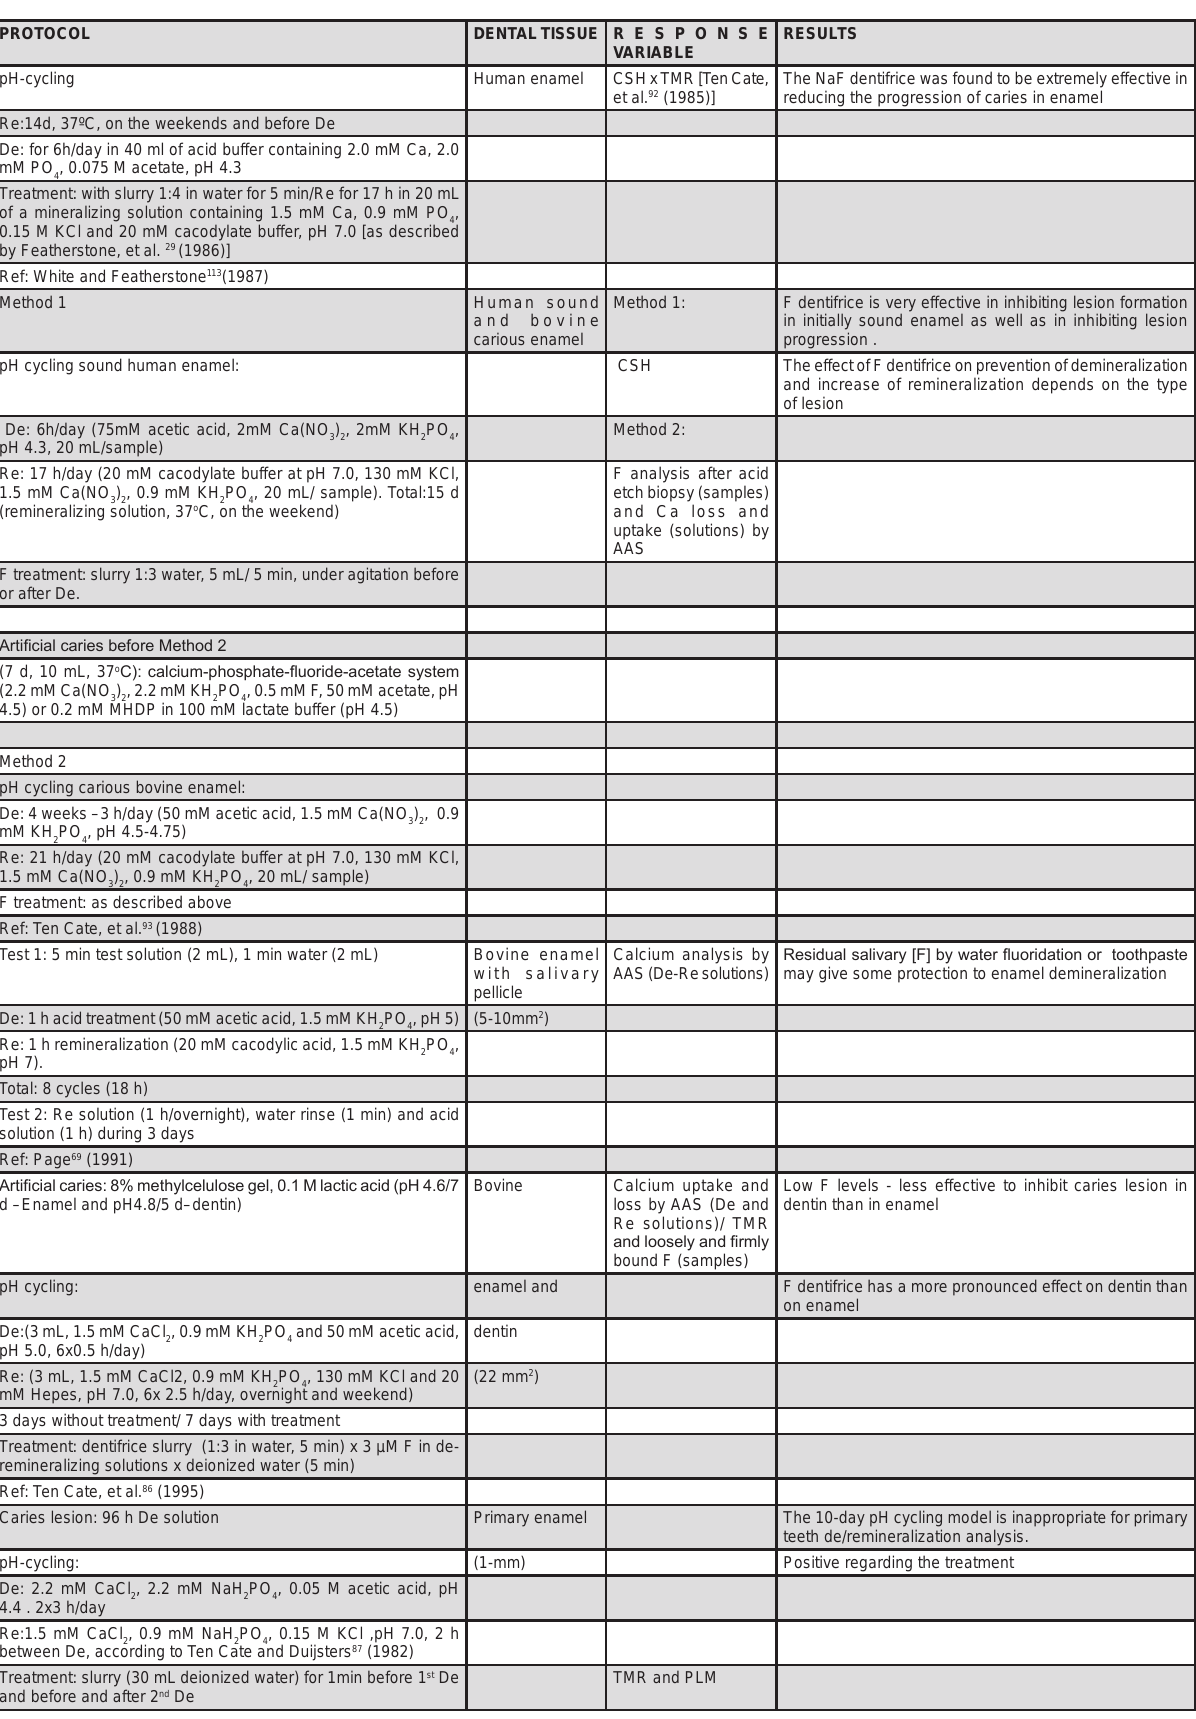
pH-cycling models for in vitro evaluation of the efficacy of fluoridated dentifrices for caries control: strengths and